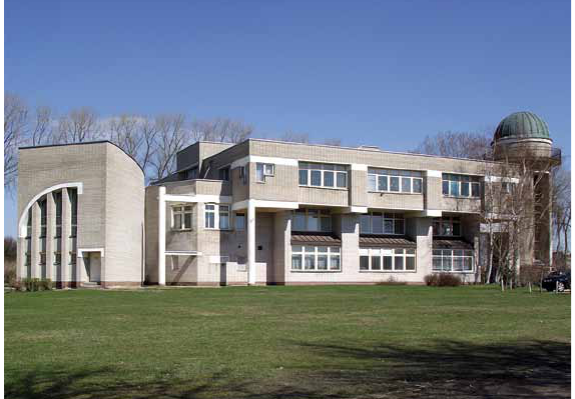
1 pav. Muzikos mokykla, Maironio g. 8, archit. I. likšienė, 1981 m., l. nekrošiaus nuotr. Fig. 1. The music school, Maironio g. 8 archit. I. likšienė, 1981, l. nekrošius photo